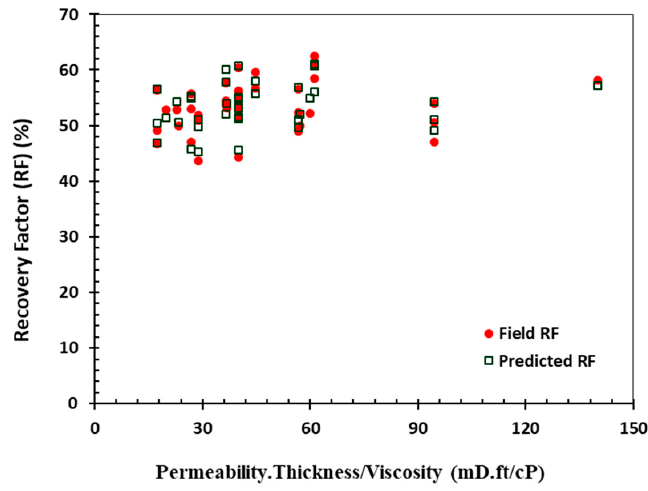
Figure 16. RF vs. oil saturation for the database analyzed.